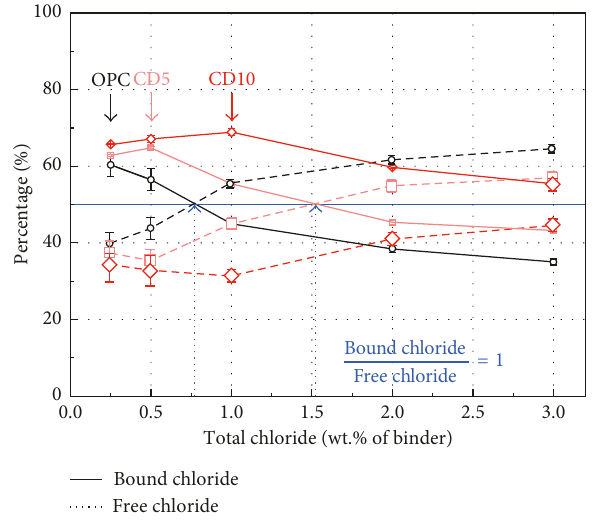
Figure 8: Percentage of bound chloride and free chloride according to total